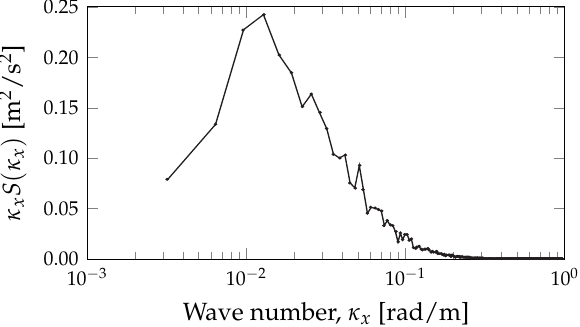
Figure 4. Longitudinal velocity spectrum, taken as the average of 12 ten-minute spectra measured along the center beam over the 2 h period preceding the gust event. During this period, the conditions were comparable (12.5 ≤ ¯ u ≤ 16.0 m/s) and the wind direction was relatively constant ( ± 5 ◦